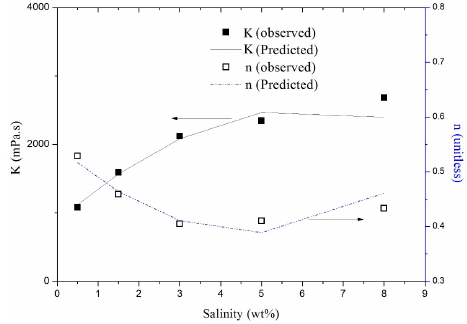
Figure 8. Effect of salinity on power-law parameters K and n on CO 2 foam.